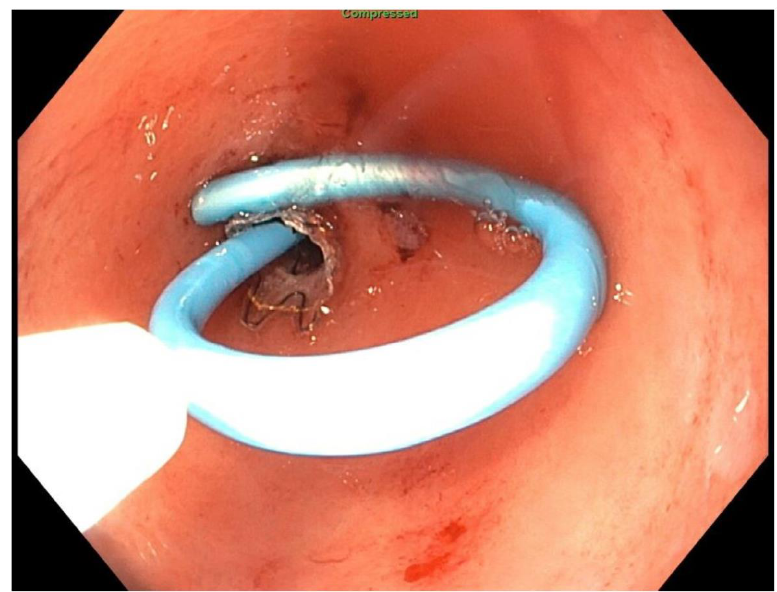
Figure 20. Pigtail stent through covered stent (endoscopic view).